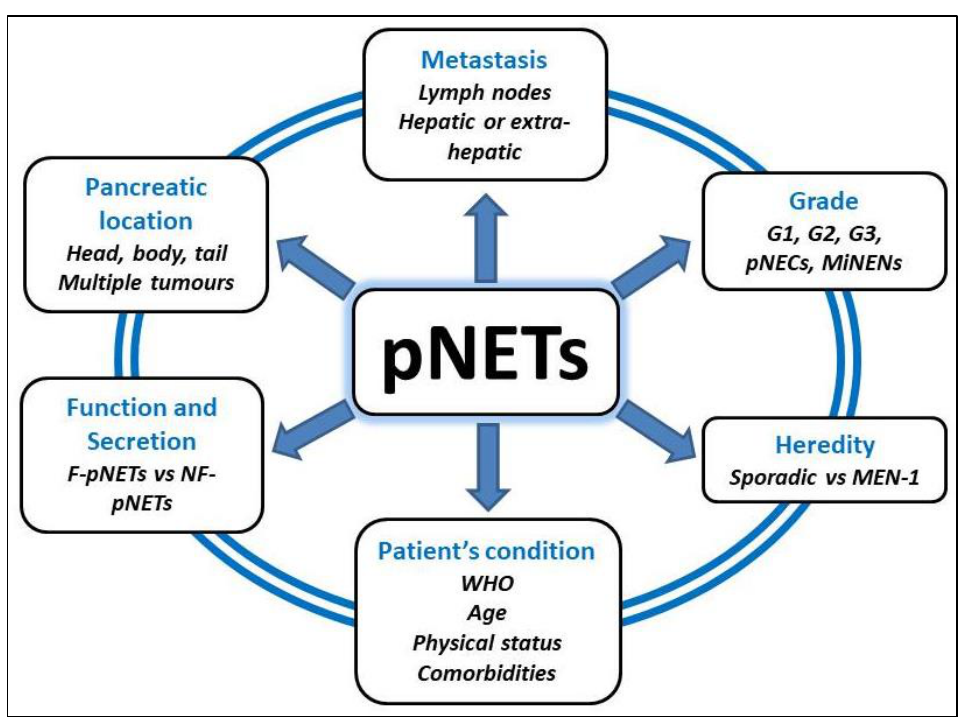
Figure 1. Different factors that have to be considered in the surgical management of patients with pNETs. Table 1. Clinical characteristics of pNETs [3–5].